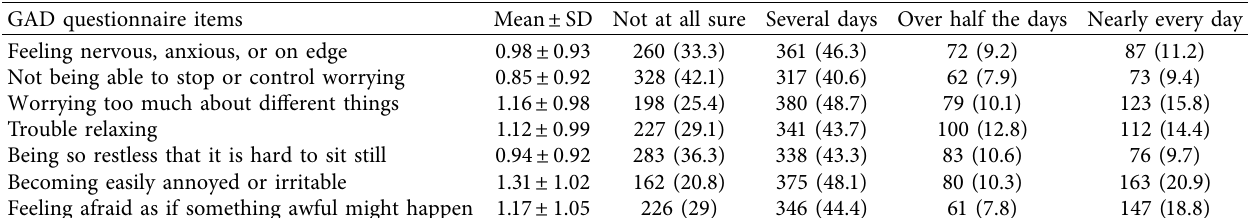
Table 2: Generalized anxiety disorder (GAD): distribution of items’ responses of pregnant women. GAD questionnaire